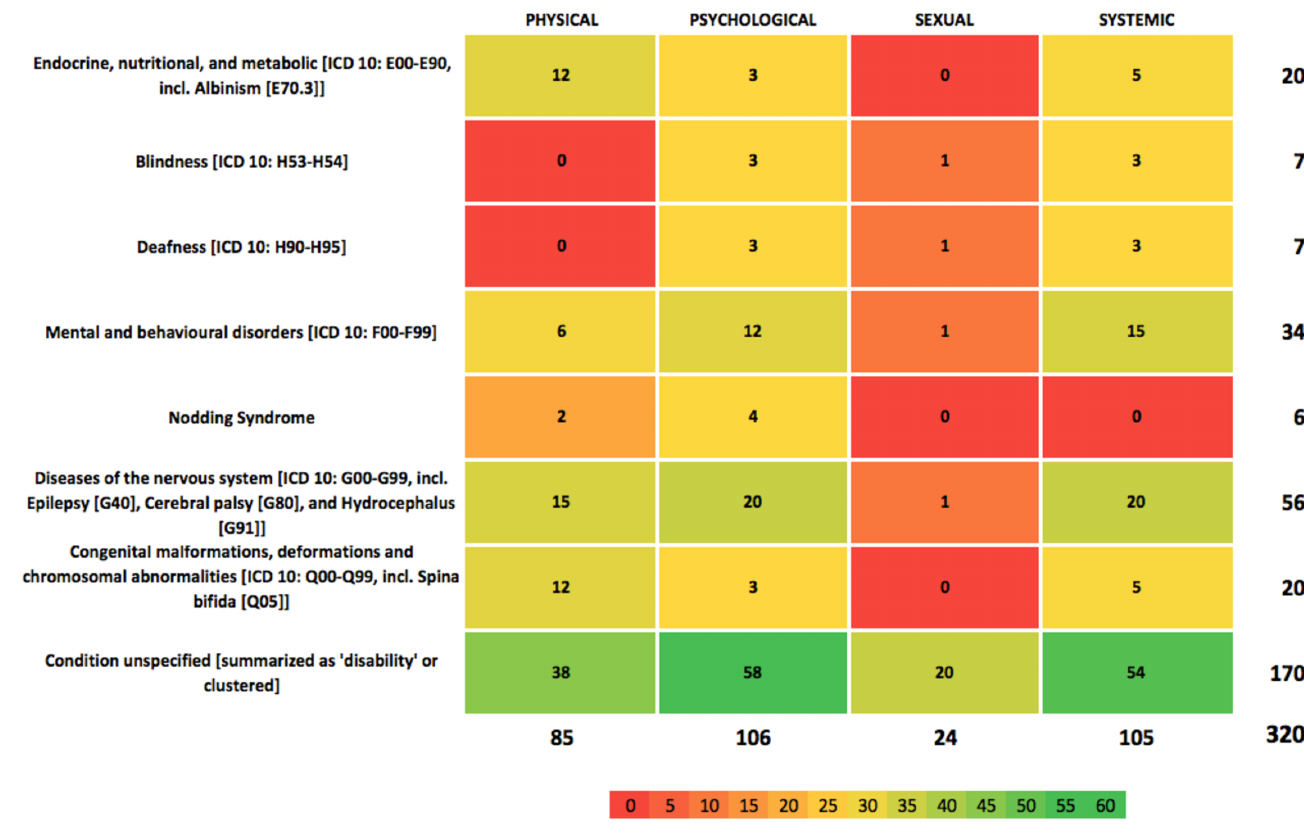
Fig 3. Heatmapof abuse and maltreatment researchstudies.